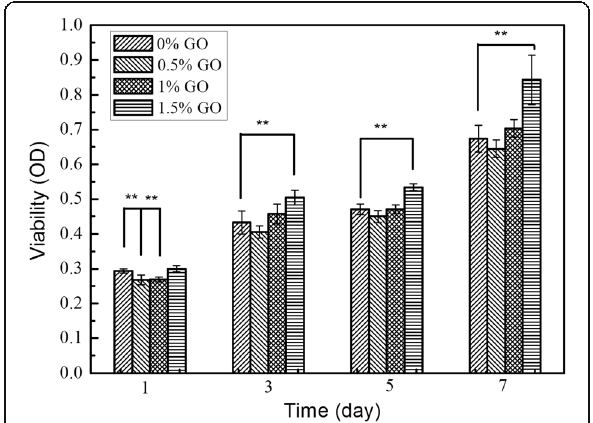
Fig. 5 Comparison of the MC3T3-E1 cells on different scaffolds surfaces; double asterisks indicate p <0.01, number of samples N